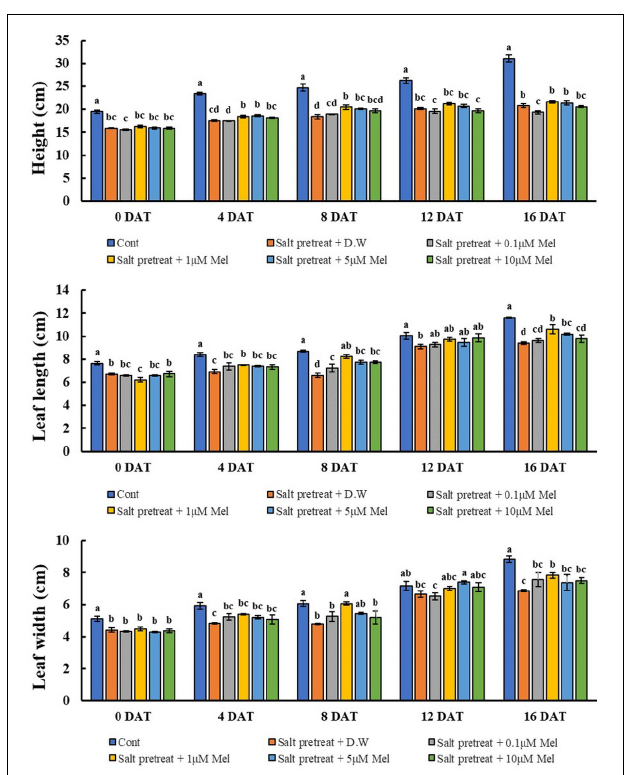
FIGURE 2 | Effect of various melatonin concentrations on the growth of salt-stressed green mustard seedlings. The results were calculated from data for 0 (0DAT), 4 (4DAT), 8 (DAT), 12 (12DAT), and 16 (16DAT) days. Treatment: control + water, 150 mM salt pre-treatment + water, 150 mM salt pre-treatment + 0.1 µ M melatonin, 150 mM salt pre-treatment + 1 µ M melatonin, 150 mM salt pre-treatment + 5 µ M melatonin, 150 mM salt pre-treatment + 10 µ M melatonin. Values show the means ± SE ( n = 3) and significant differences at p < 0.05 in accordance with Duncan’s multiple range